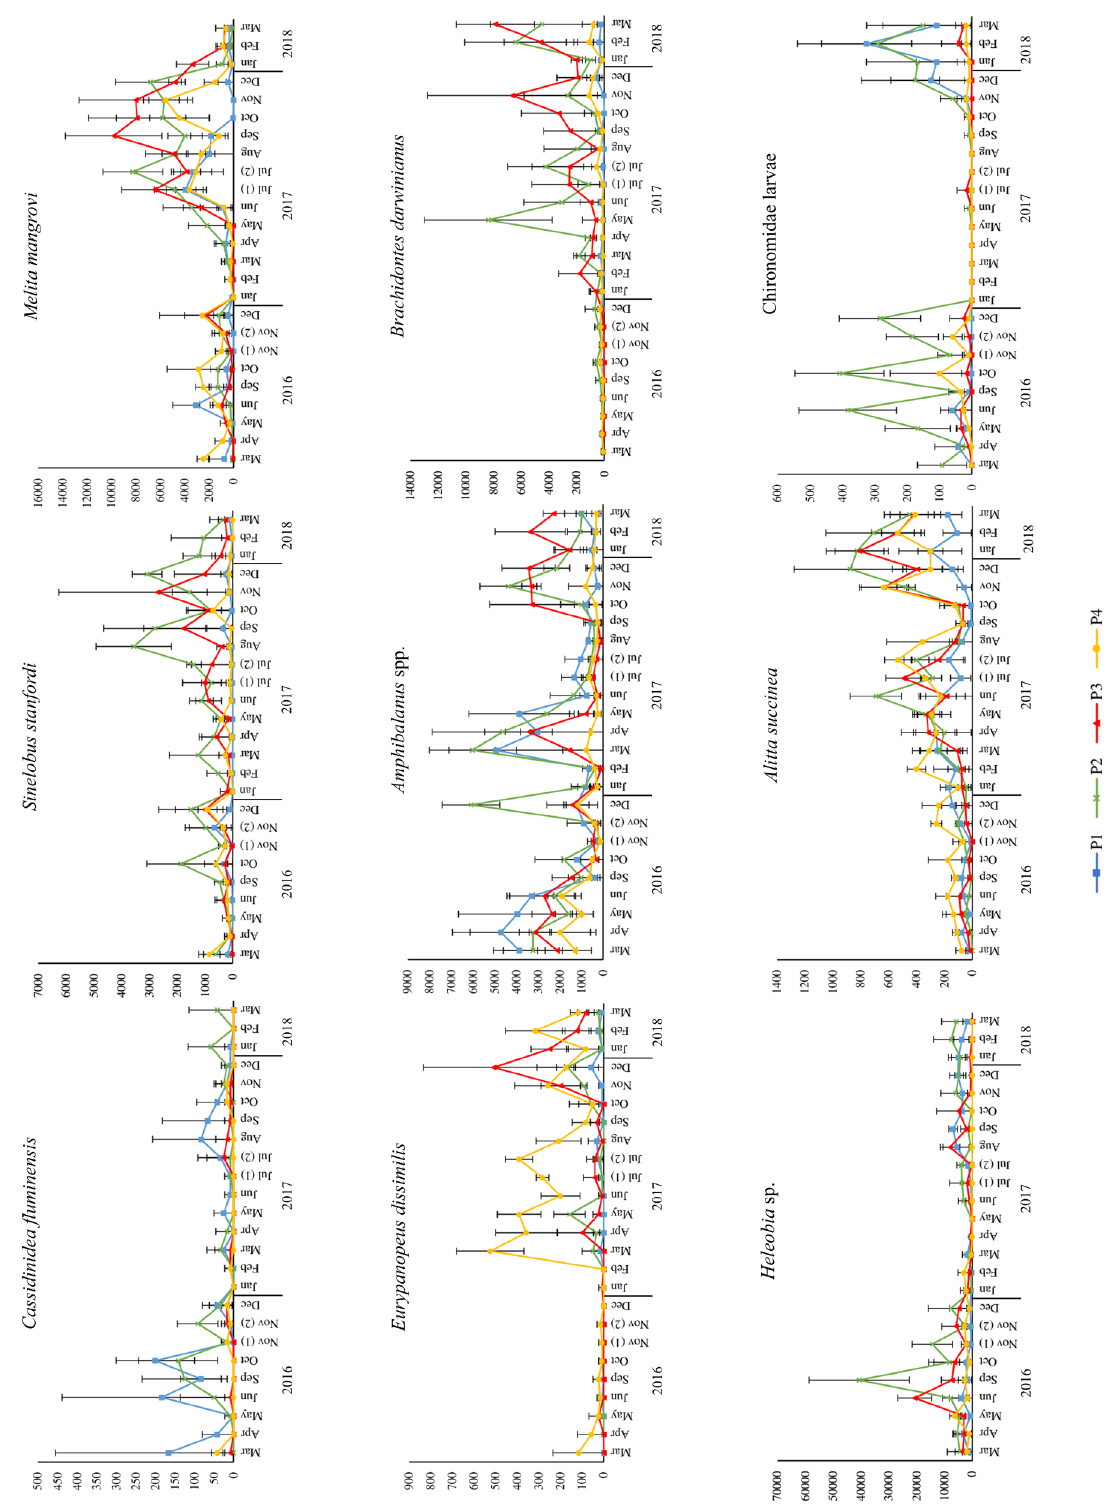
Figure 4. Temporal variation of the mean density (with standard deviation) for each species of the benthic macrofauna associated to Mytilopsis leucophaeata per sampling site, between March 2016–March